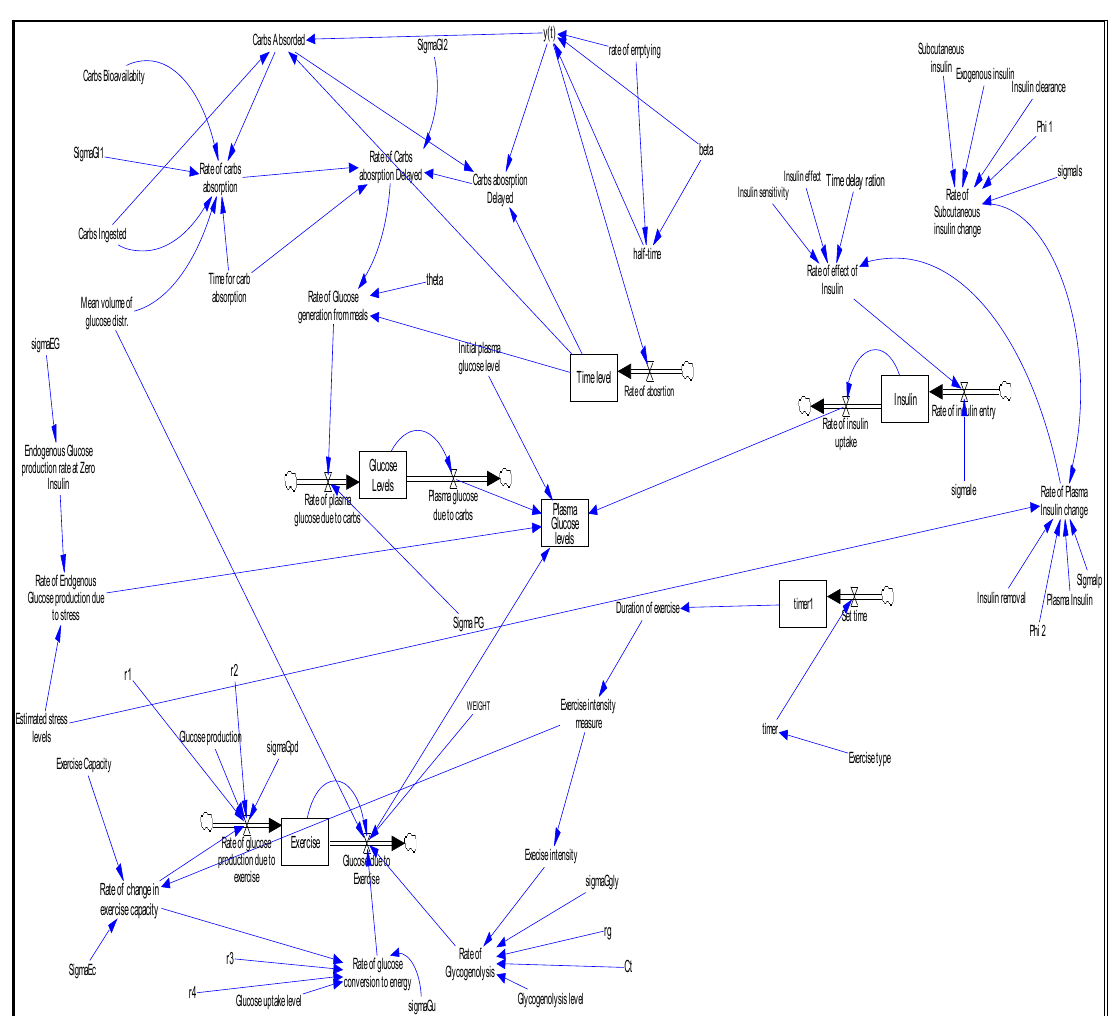
Figure 2. Model of the semi ‐ closed causal loop diagram of the interaction between meal, physical exercise and stress in glucose ‐ insulin dynamics.